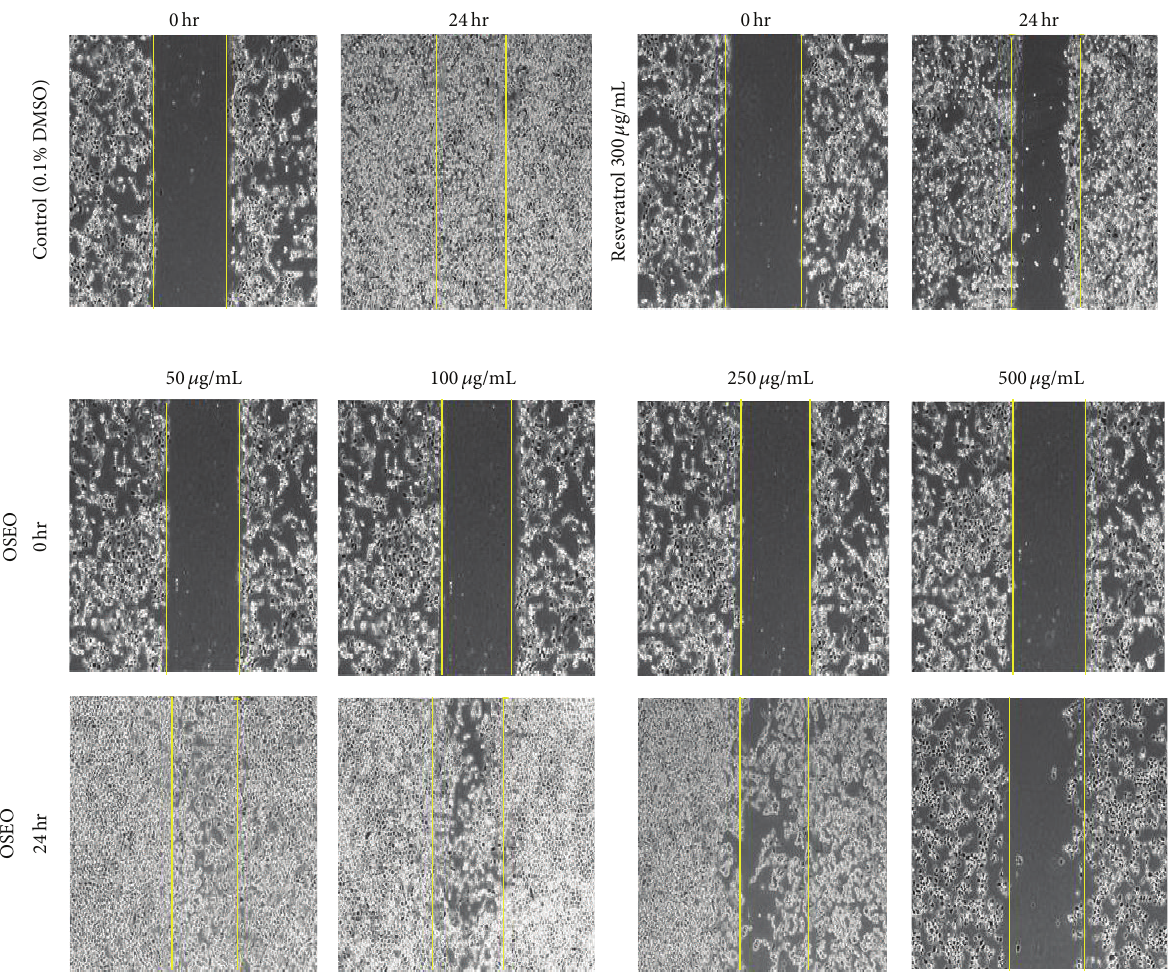
Figure 1: Effect of OSEO on migration of MCF-7 cells at various concentrations (50–500 𝜇 g/mL). Cells treated with vehicle (0.1% DMSO) served as negative control and cells treated with resveratrol (300 𝜇 g/mL) served as positive control. Photographs were captured at 0h and 24 h of treatment on an inverted microscope (Nikon ECLIPSE TI-S) at 20x magnification. The gap or “scarring” area is marked with yellow lines.